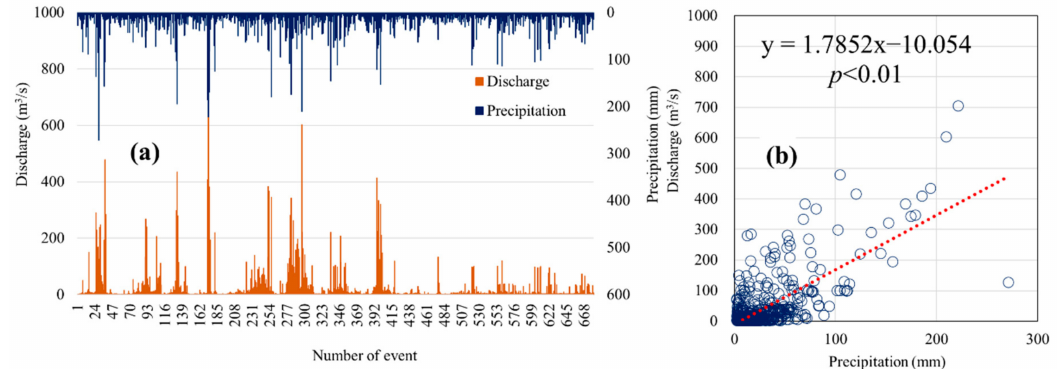
Figure 5. Variation in precipitation and discharge during the period of study: ( a ) changes in precipitation and discharge; ( b ) scatter plot between precipitation and